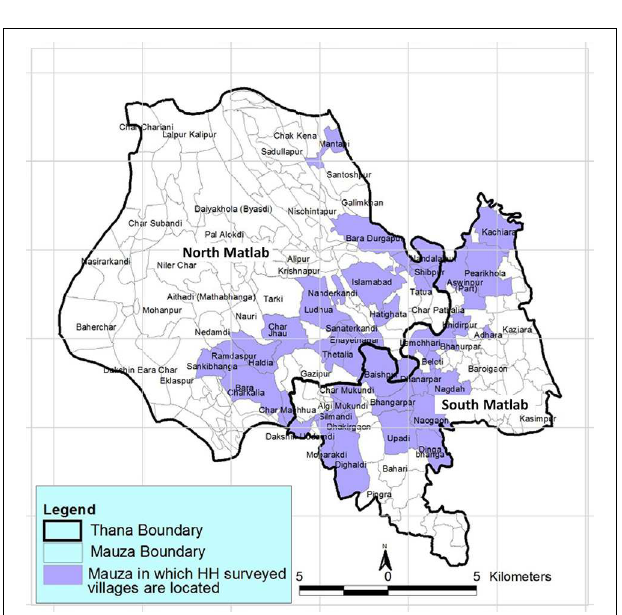
FIGURE 3 | Mauzas in which HH surveyed villages are located. FIGURE 4 | Locations of the safe water options surveyed.